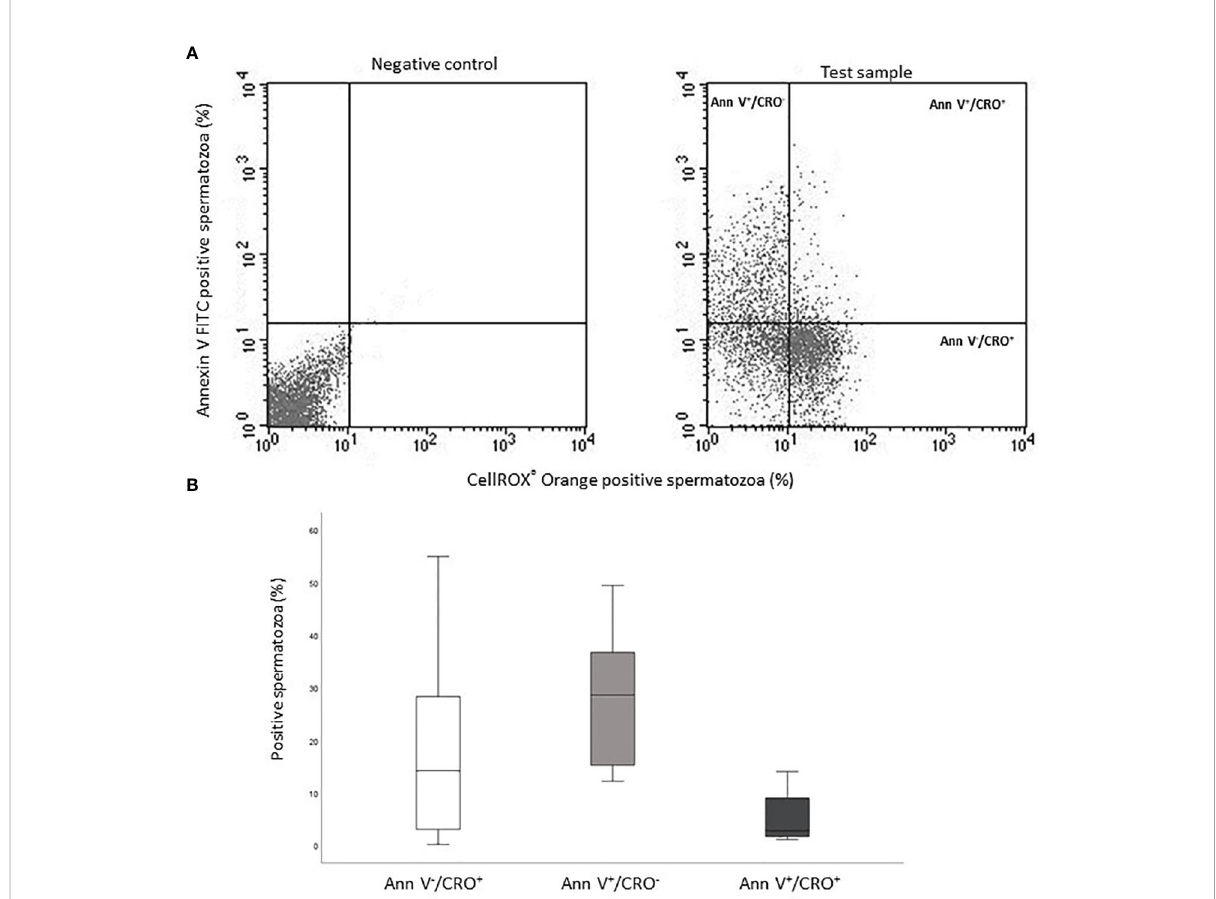
FIGURE 8 (A) Typical dot plots representing negative control (left) and test sample (right) related to CellROX ® Orange (red fl uorescence, CRO) and Annexin V (green fl uorescence, Ann V). (B) Box plots of the percentages of CellROX ® Orange positive and Annexin V negative spermatozoa (Ann V - /CRO + ), CellROX ® Orange negative and Annexin V positive spermatozoa (Ann V + /CRO - ) and CellROX ® Orange and Annexin V double positive spermatozoa (Ann V + /CRO + ),